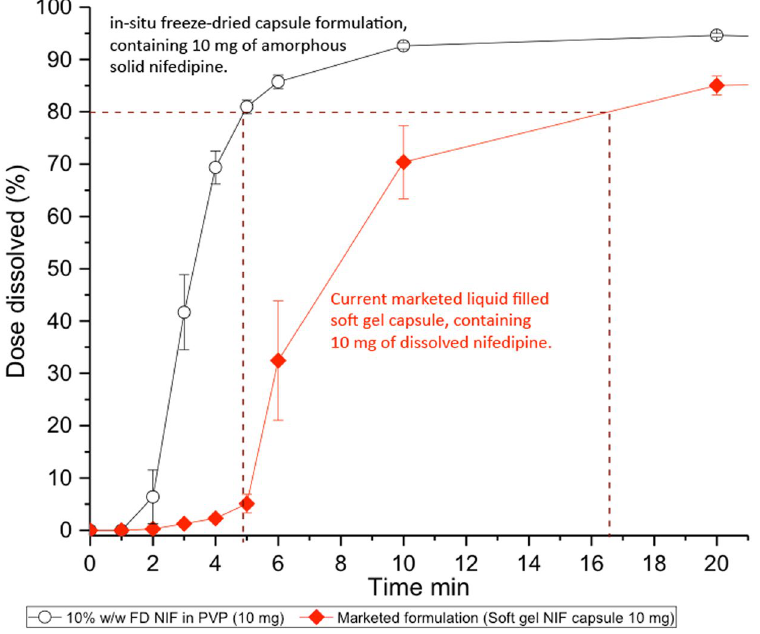
Figure 8. Comparing the dissolution profile of the in-situ capsule FD formulation 10% w/w NIF in PVP against the soft gel (liquid filled) marketed formulation TEVA 10 mg NIF. Average T80 for the marketed formulation is approximately 3 times longer than that of the in-situ capsule FD formulation (10% w/w NIF in PVP). Error bars represent standard error of n =